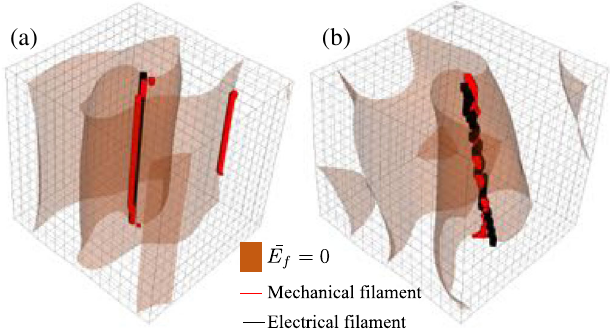
FIG. 8. Electromechanical phase singularities in the presence of a single scroll wave in a 3D tissue ( 1 . 2 × 1 . 2 × 1 . 2 cm). (a) All fibers are uniformly aligned along the x axis. (b) Fibers ortho- tropically stacked and rotating by 90°, parallel to the x axis at the bottom and parallel to the y axis at the top surface, respectively. Red lines represent lines of mechanical phase singularity or mechanical filaments, and the black line at the center represents the electrical filament or scroll wave core. The isosurface is ¯ E ¯ E 0 , where ¯ E presenting is the normalized strain f ¼ xx ¼ f along the fiber that is used to calculate the